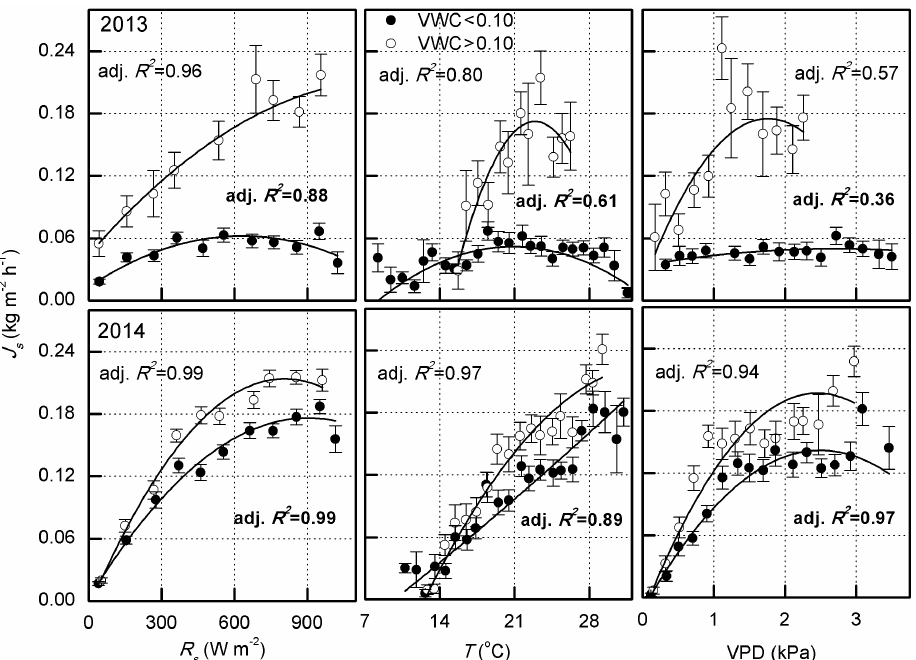
Figure 4. Sap flow per leaf area ( J s ) in non-rainy, daytime hours during the mid-growing season of 1 June to 31 August for both 2013 and 2014 as a function of shortwave radiation ( R s ), air temperature ( T ), and vapor pressure deficit (VPD) under high volumetric soil water content (VWC > 0.10m 3 m − 3 both in 2013 and 2014) and low VWC ( < 0.10m 3 m − 3 , 2013 and 2014). J s is given as binned averages according to R s , T , and VPD based on increments of 100Wm − 2 , 1 ◦ C, and 0.2kPa, respectively. Bars indicate standard error.